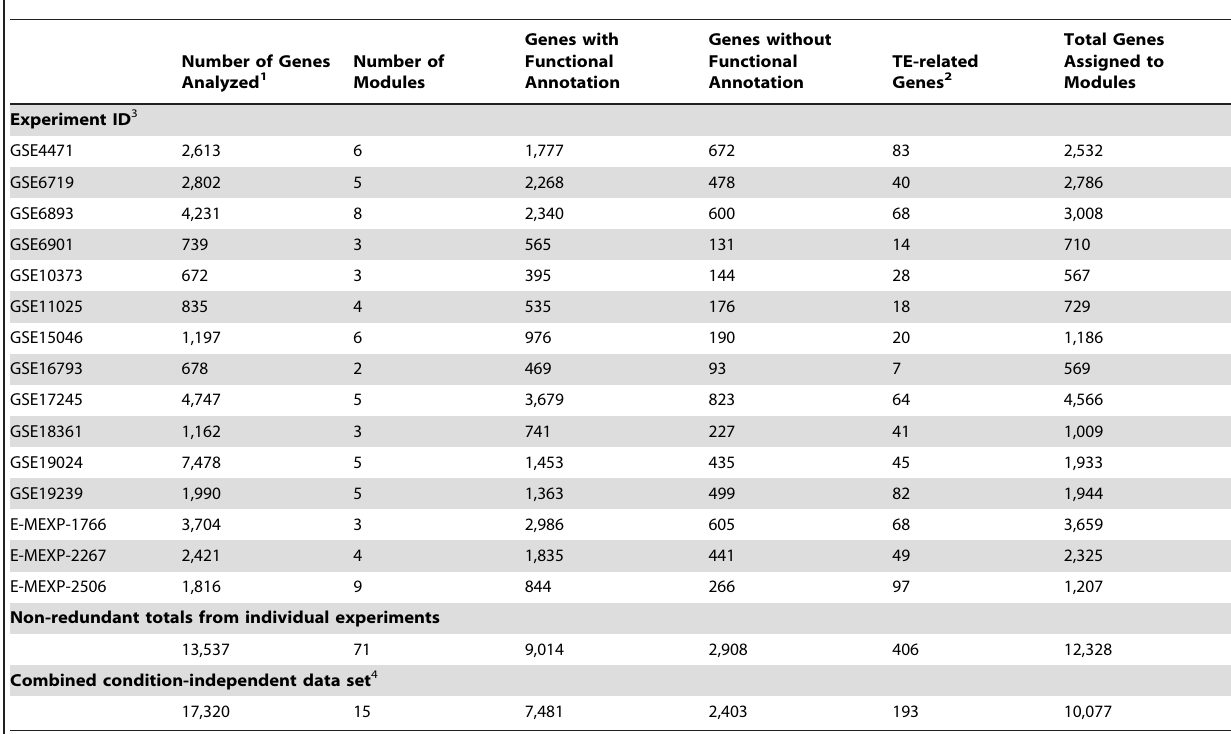
Table 2. Numbers of genes and annotation status of genes assigned to modules by two analysis